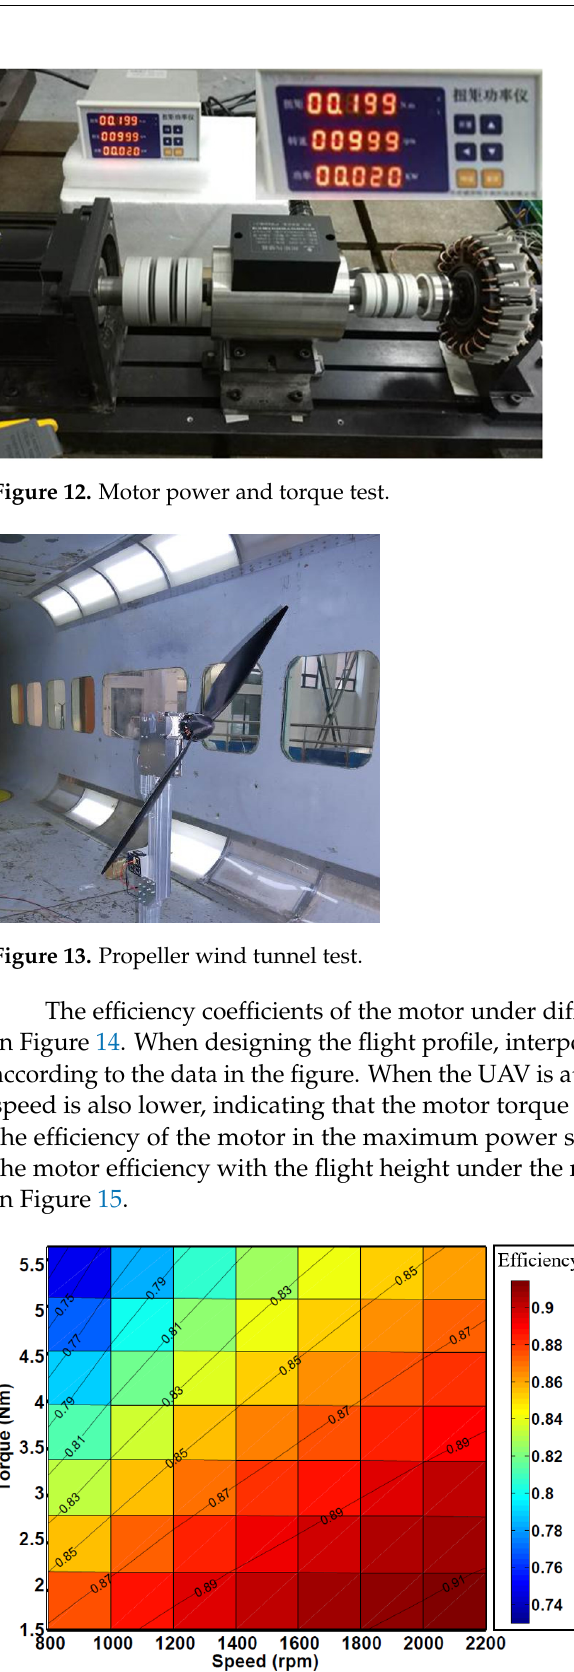
Table 5. Dynamic system parameters.